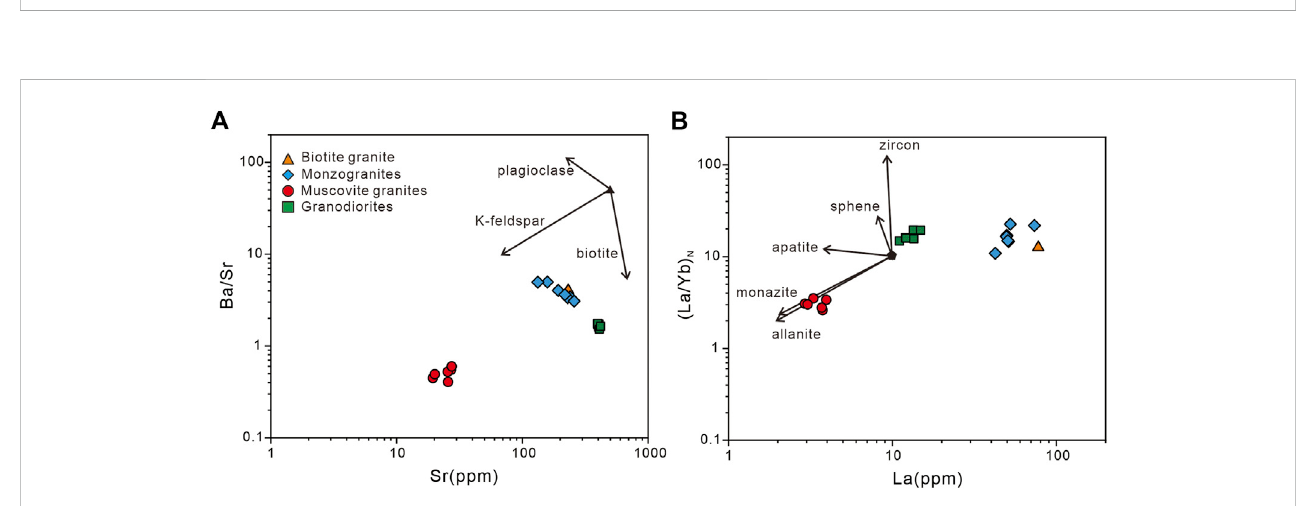
FIGURE 10 (A) Ba/Sr vs . Sr and (B) (La/Yb) N vs . La diagrams (Wu et al.,